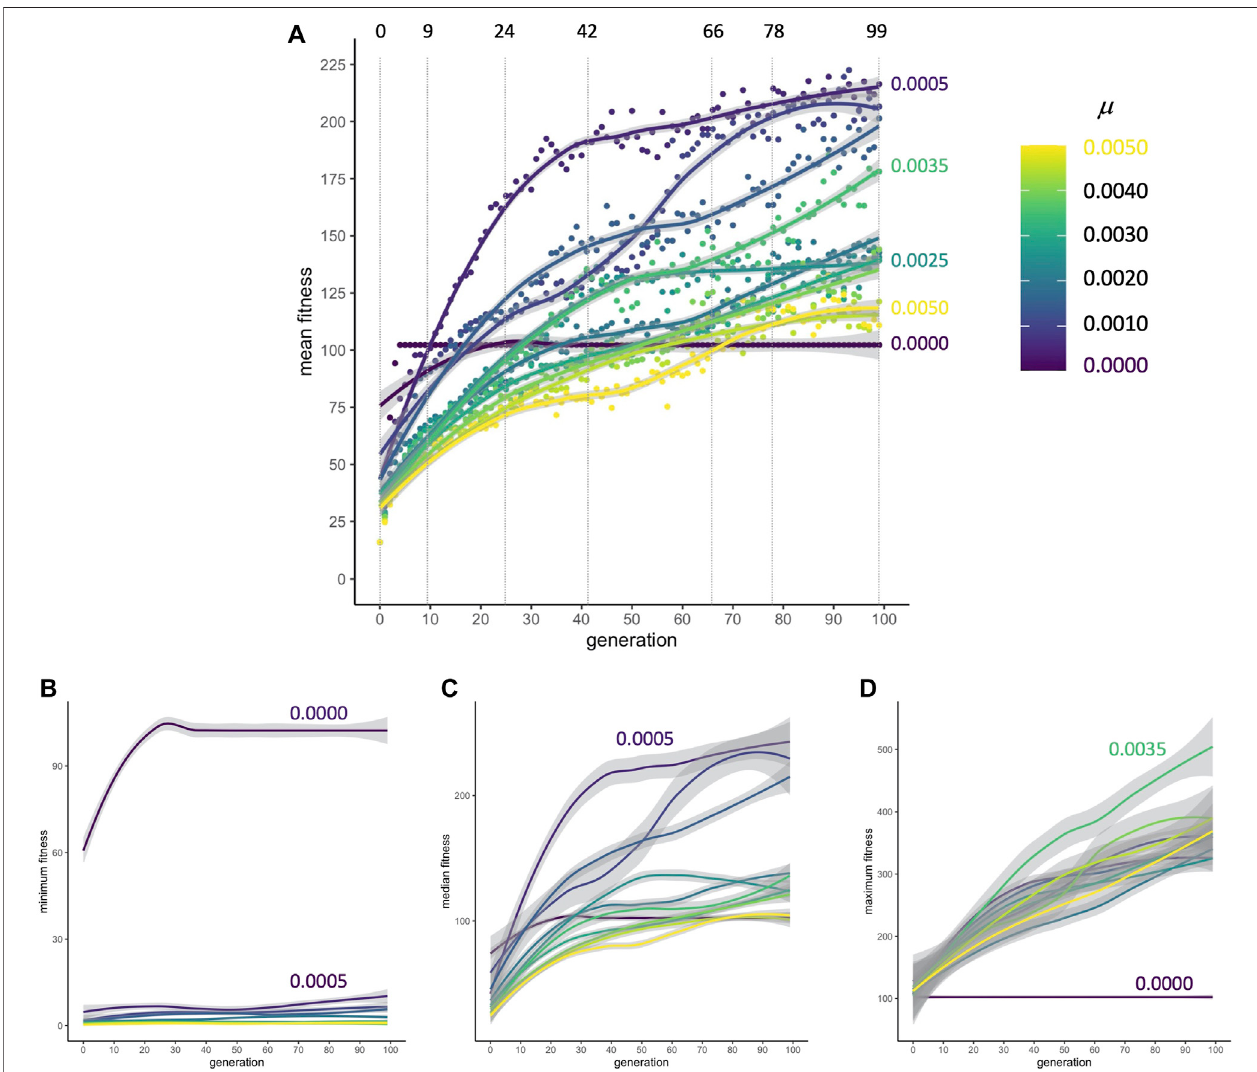
FIGURE4 | Adaptiveevolution. (A) Mean fi tness. Nomatter the rate ofmutation, populations increase their mean fi tness rapidly from generation0 to9 in aprimary burst. Thedashed verticallines indicate transitional and representative generationsthatwillbesampled indetailtoexamine thein fl uencesofdevelopmentandselection. Points are means, pooled across populations ( n (cid:1) 9). Lines are fourth-order polynomial fi ts, with gray shading representing the local 95% con fi dence interval. (B) The minimum individual fi tness is low in every generation except when mutation is absent (violet line), indicating that mutation in asexual lineages disrupts the genomes of at least some of the adapted morphologies. (C) Median individual fi tness marks the point of truncation for the selection algorithm. (D) In contrast to the populations ’ mean (A) , minimum (B) , and median (C) , the maximal fi tness of individuals increases steadily when mutation is present. For (B – D) , the lines are locally-weighted regressions (LOESS) representing the mean of that measure, pooled across populations, with gray shading representing the local 95% con fi dence interval ( n (cid:1) 540).